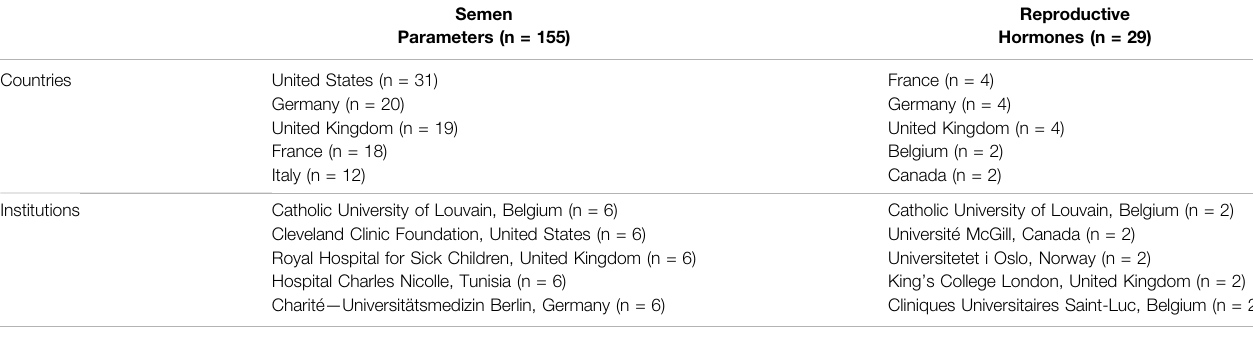
TABLE 2 | Top fi ve countries and institutions contributing in the fi eld of radiotherapy associated with semen parameters and male reproductive